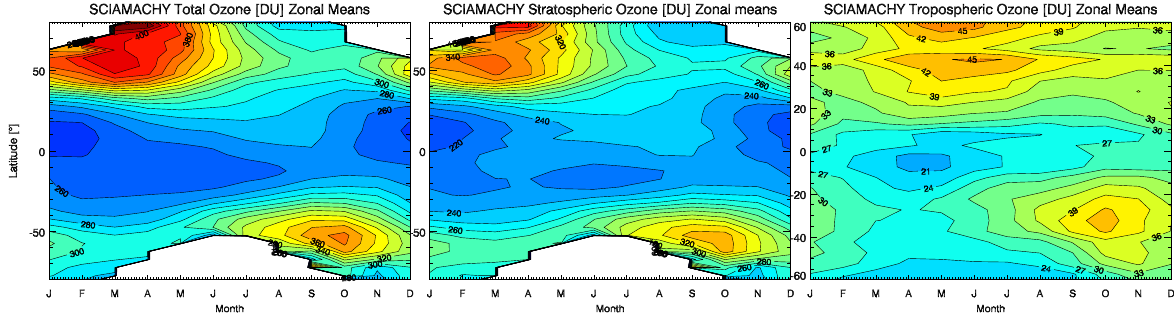
Figure 13. Zonal mean climatology of ozone in Dobson units; from left to right: total ozone column, stratospheric ozone column and tropospheric ozone column derived from October 2004 to December 2010 from SCIAMACHY measurements in 5 ◦ latitude bins.